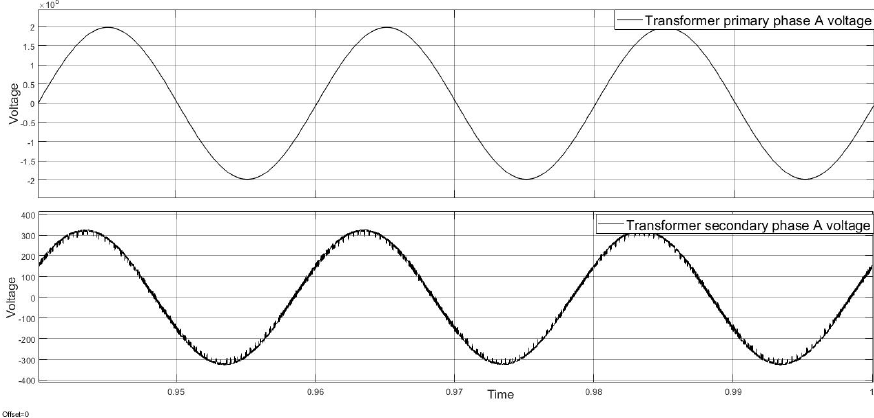
Figure 7. Transformer primary and secondary A phases voltage signals .